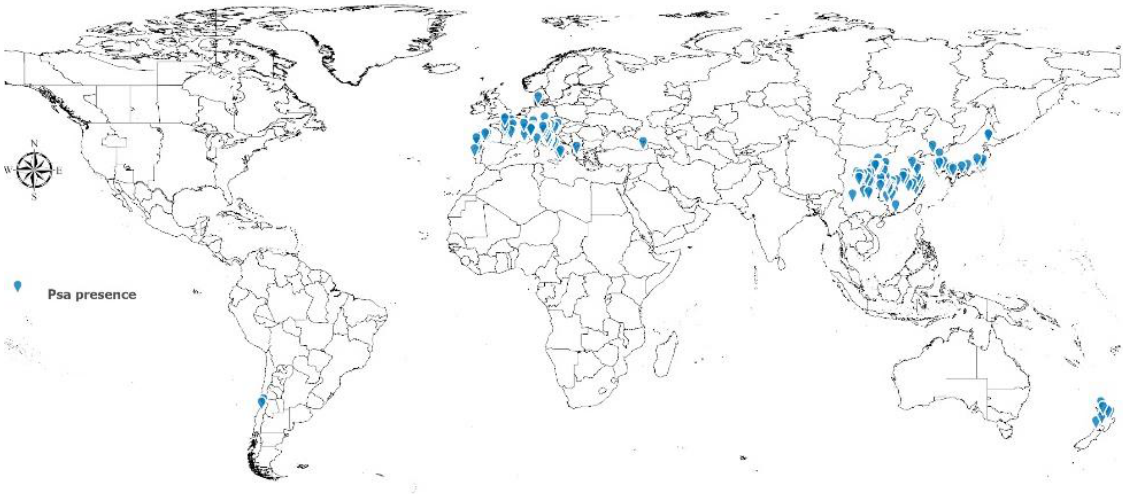
Figure 2. Current global distribution of Kiwifruit bacterial canker disease (Psa).